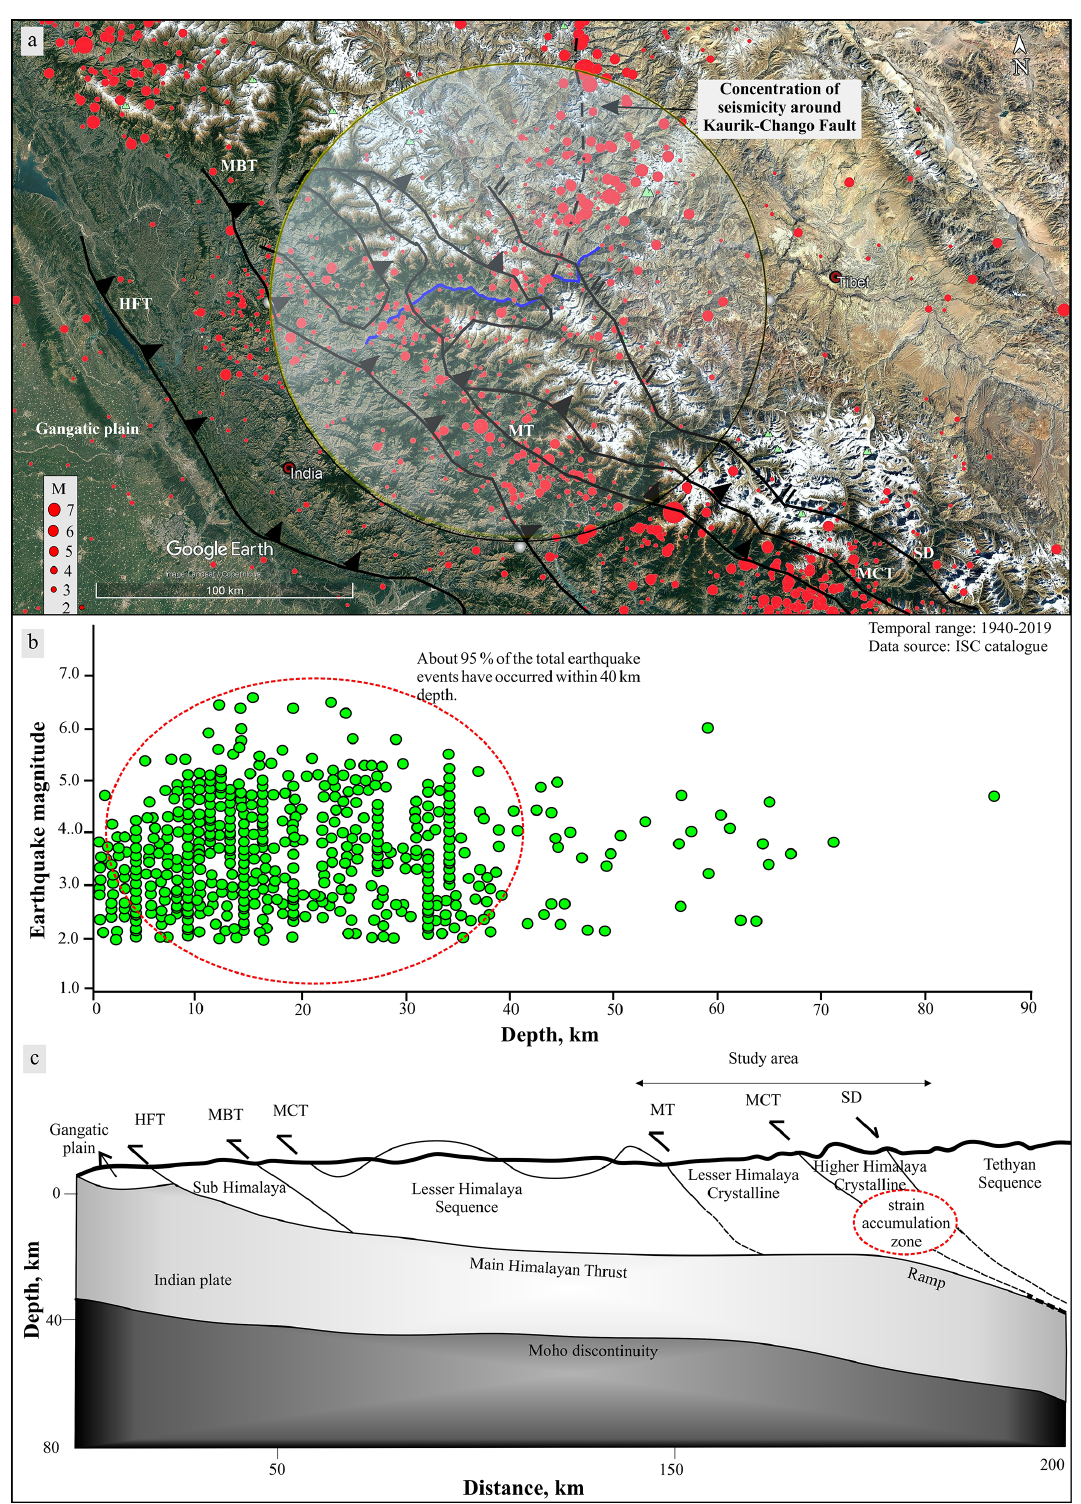
Figure 12. Earthquake distribution. (a) Spatial variation of earthquakes (© Google Earth). The transparent circle represents the region within a 100km radius of the Satluj River (blue line). The dashed black line represents the seismic dominance around the Kaurik–Chango fault. (b) Earthquake magnitude vs. focal depth. The dashed red region highlights the concentration of earthquakes within 40km depth. (c) Cross section view (based on Hazarika et al., 2017; Bilham, 2019). The dashed red circle represents the zone of strain accumulation caused by the Indian and Eurasian plate collision (Bilham, 2019). ISC: stands for International Seismological Centre. HFT stands for Himalayan Frontal